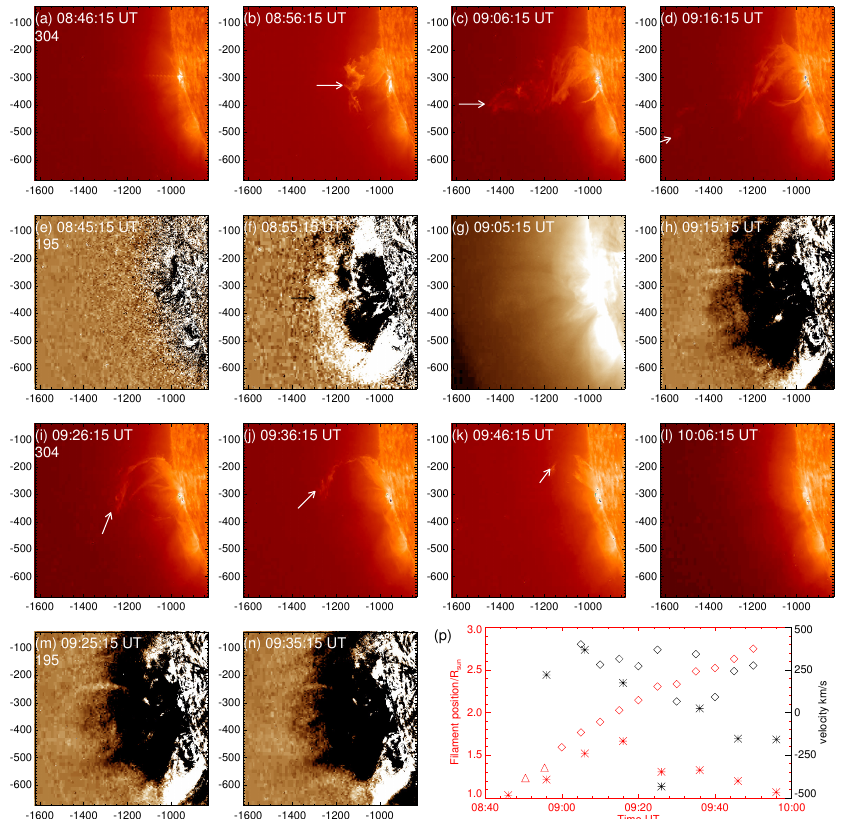
Figure 1. Dynamical evolution of the filament eruption observed by STEREO-A. The first (Panel a – d ) and third row (Panel i – l ) is 304 Å image. The second (Panel e , f , and h ) and fourth (Panel m – n ) is base difference image of 195 Å, with one direct image shown in (Panel g ). The unit of the X- and Y-axis is the acrsecond from the solar center. Panel p: red stars represent the position of the top position of the filament material observed by EUVI A as indicated by arrows, and black stars indicate the velocity deduced from the red stars; red diamonds represent the position of the bright front observed by COR1 along the black line as shown in Figure 2h and black diamonds indicate the velocity deduced from the red diamonds; the red triangles indicate the position of the leading edge of the coronal transient as indicated by black arrow in Figure